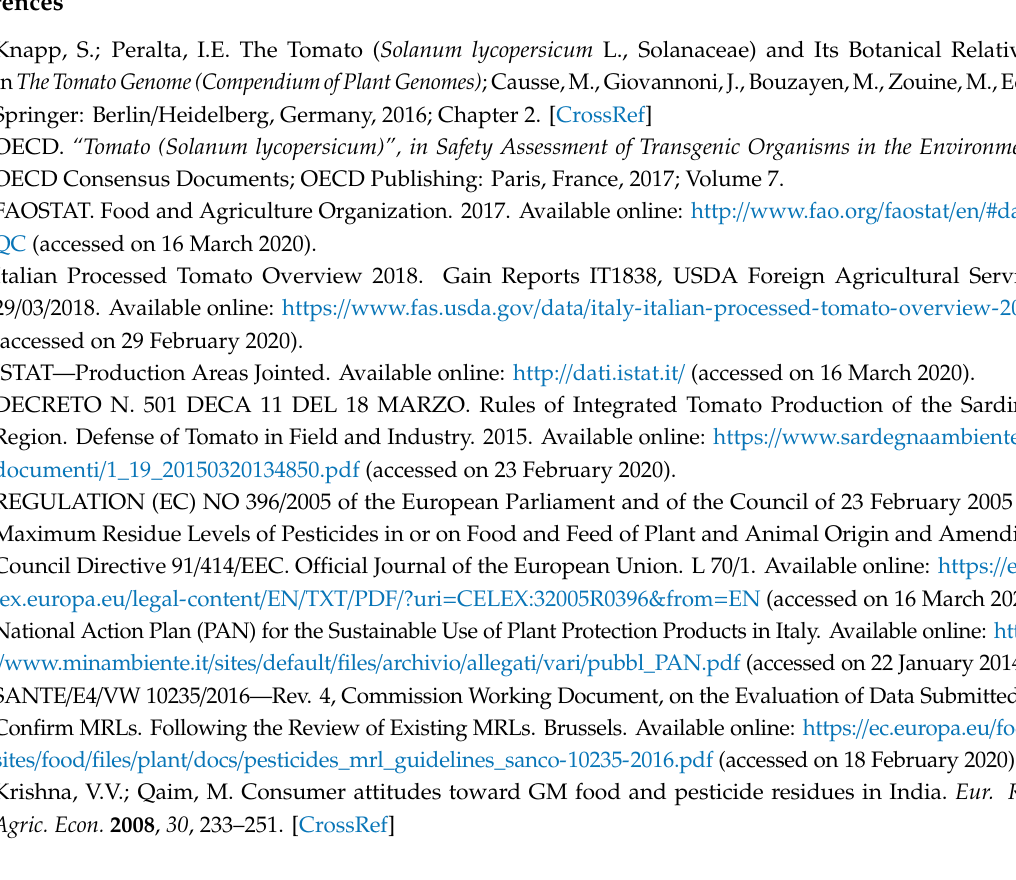
Table S1: Active ingredients, types, and LC-MS / MS-MRM m / z ions used for qualitative and quantitative